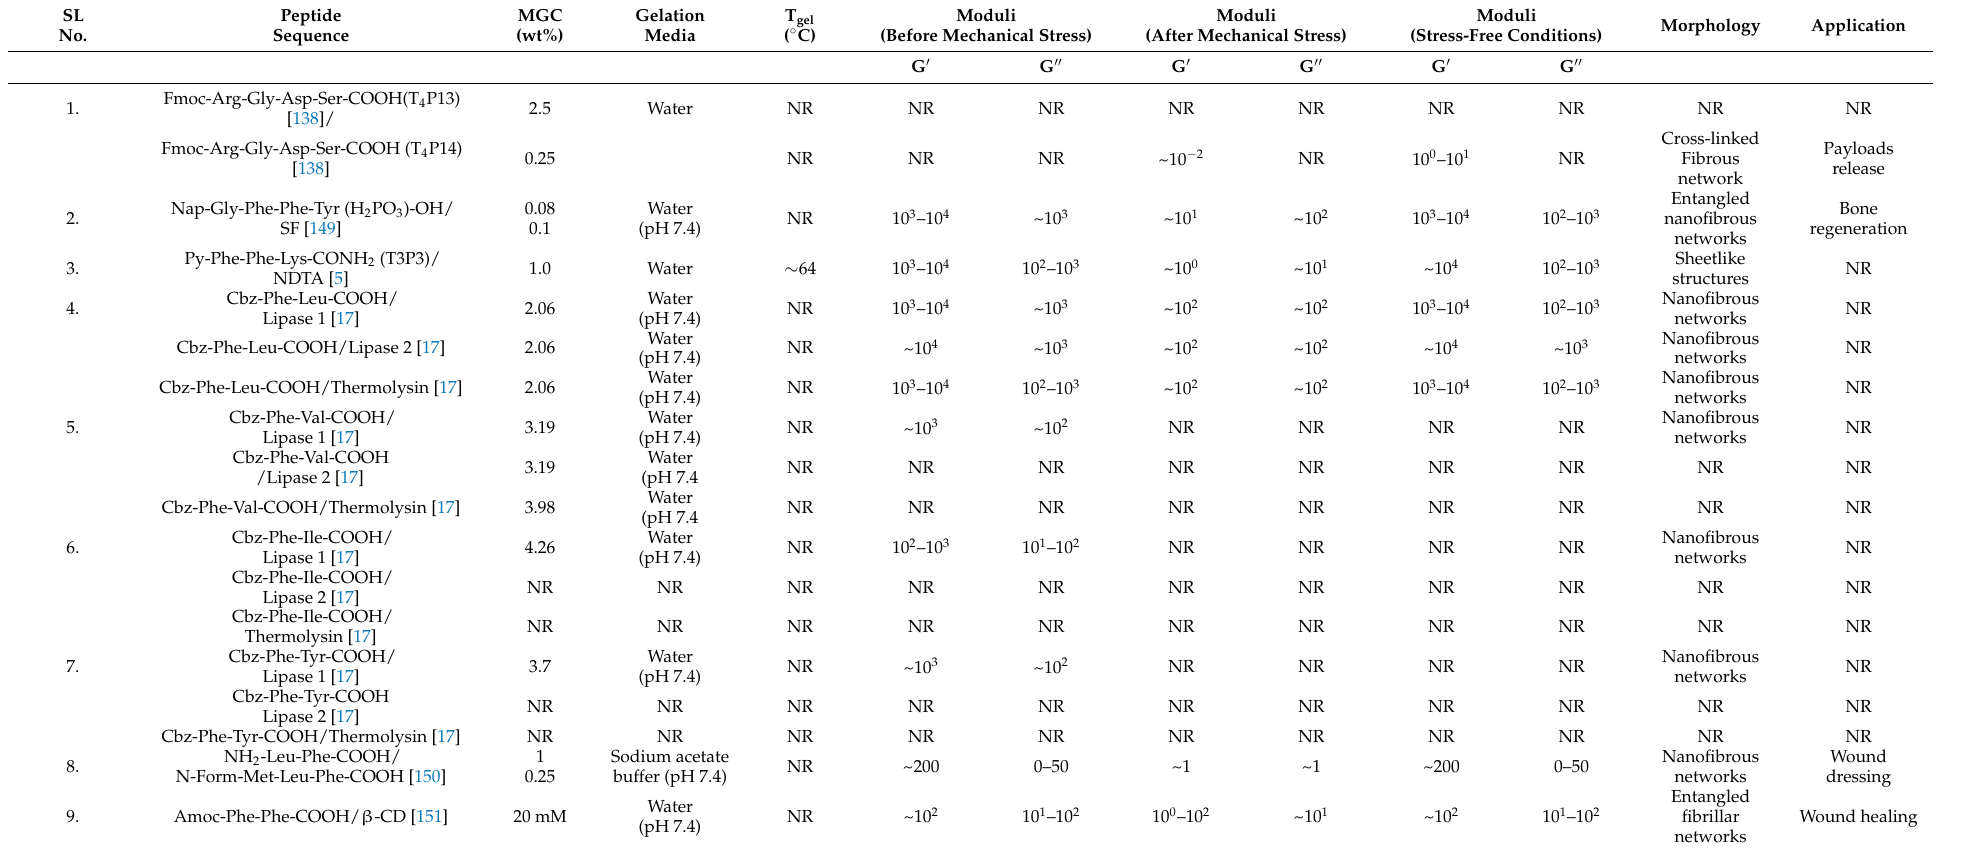
Table 6. List of co-assembled hydrogelators and respective gelation